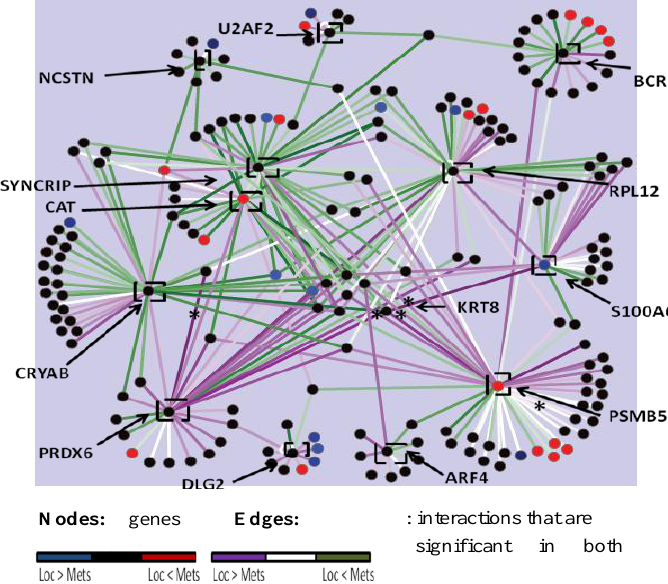
Figure 3. Labeled black squares show 12 differentially organized hubs (ΔPCC ≥ 0.4, p = 0, interactors ≥ 7). Nodes are genes and their colour reflects fold change in expression in the metastatic samples, only for significantly differentially expressed genes (t-test p ≤ 0.001). Only interactors of a significant hub whose expression is significantly correlated (PCC p ≤ 0.001) with expression of that hub in either the localized or metastatic samples are included. Edges depict interactions, and their colour reflects change in co-expression between metastatic samples and localized samples (green: correlation increased in metastatic samples, purple: correlation decreased in metastatic samples). Asterisks denote co-expressions that are significant (PCC p ≤ 0.001) in both localized and metastatic